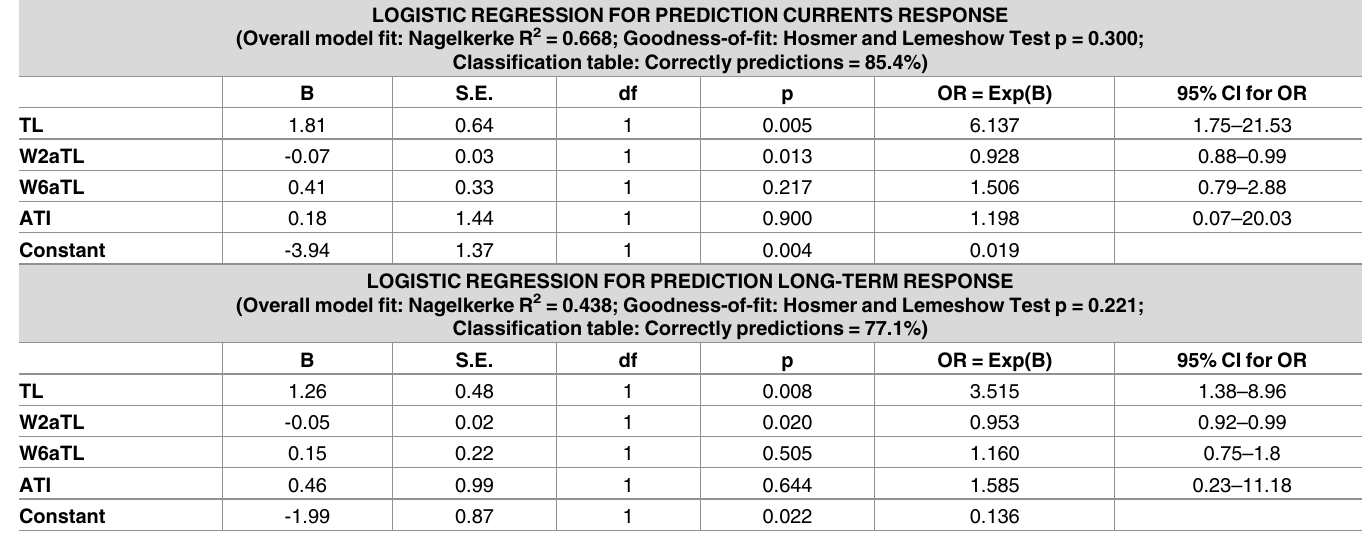
Table 2. Results of logistic regression analysis for prediction current (at inclusion) and long-term response (after 6-months follow-up).